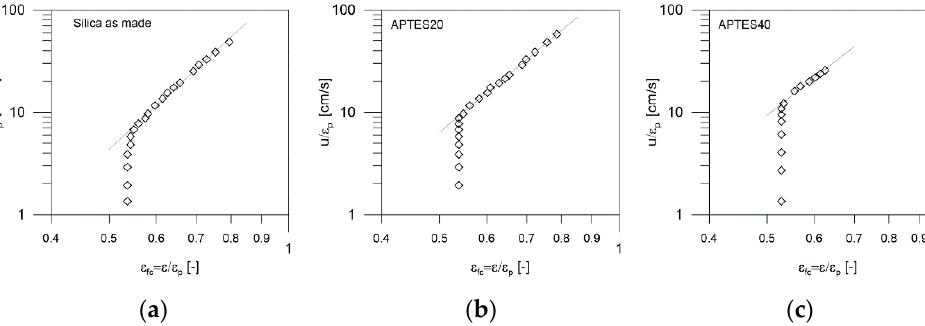
Figure 9. Typical diagram of fluidization tests in a confined bed: pressure drop, Δ P conf , and heigh of the sorbent bed, H fc , versus gas velocity. ( a ) as-made silica; ( b ) APTES20; ( c ) APTES40.